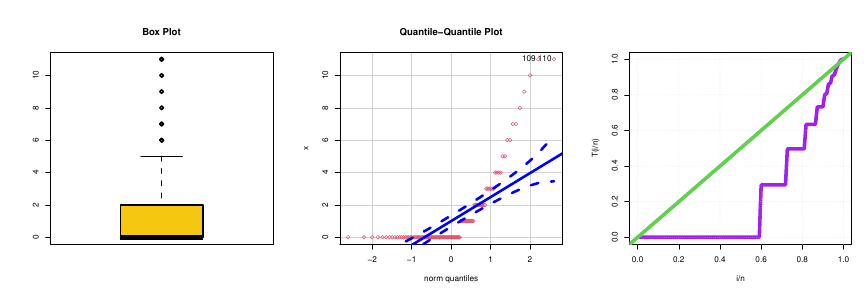
Figure 7 – Box plot, Q-Q plot and TTT plot for the counts of cysts of kidneys data.